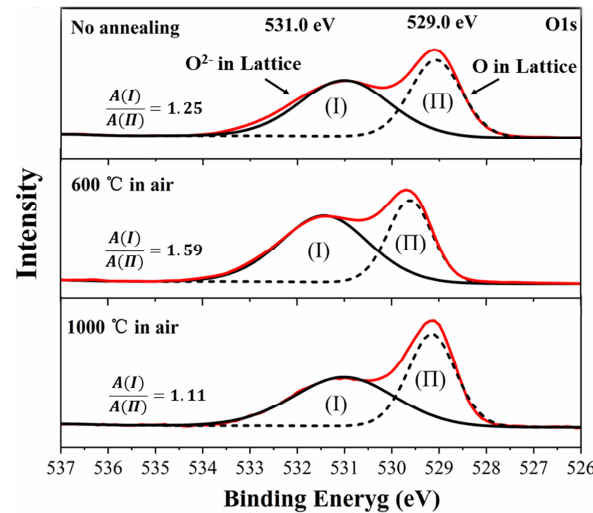
Figure 8. O1s photoelectron peaks of In 2 O 3 in XPS at different annealing conditions.